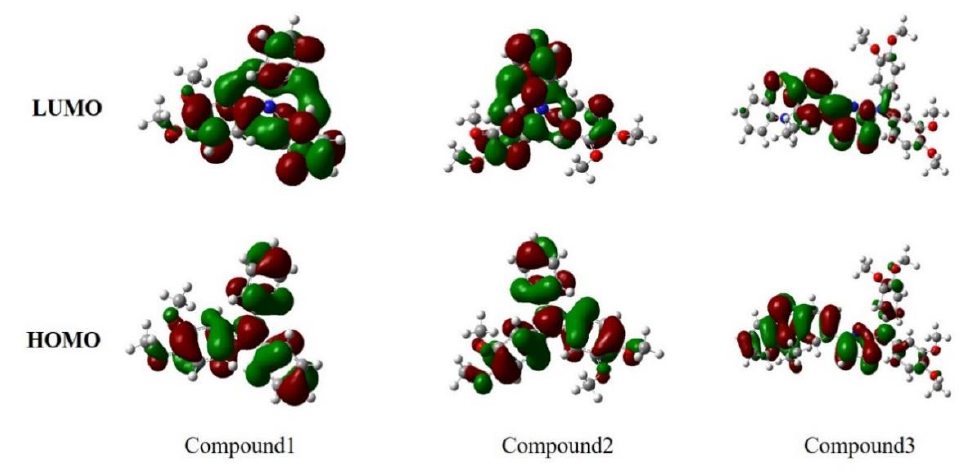
Figure 5. The molecular orbitals HOMO and LUMO of the three original molecules.